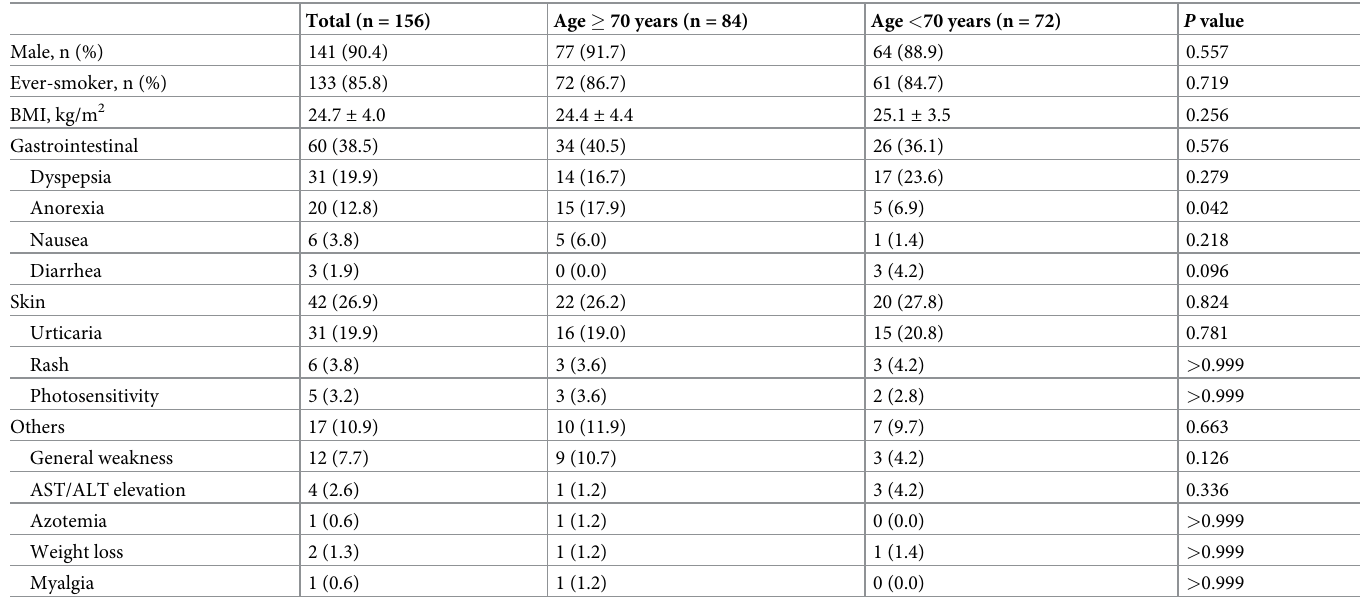
Table 4. Comparison of baseline characteristics and adverse events according to age.